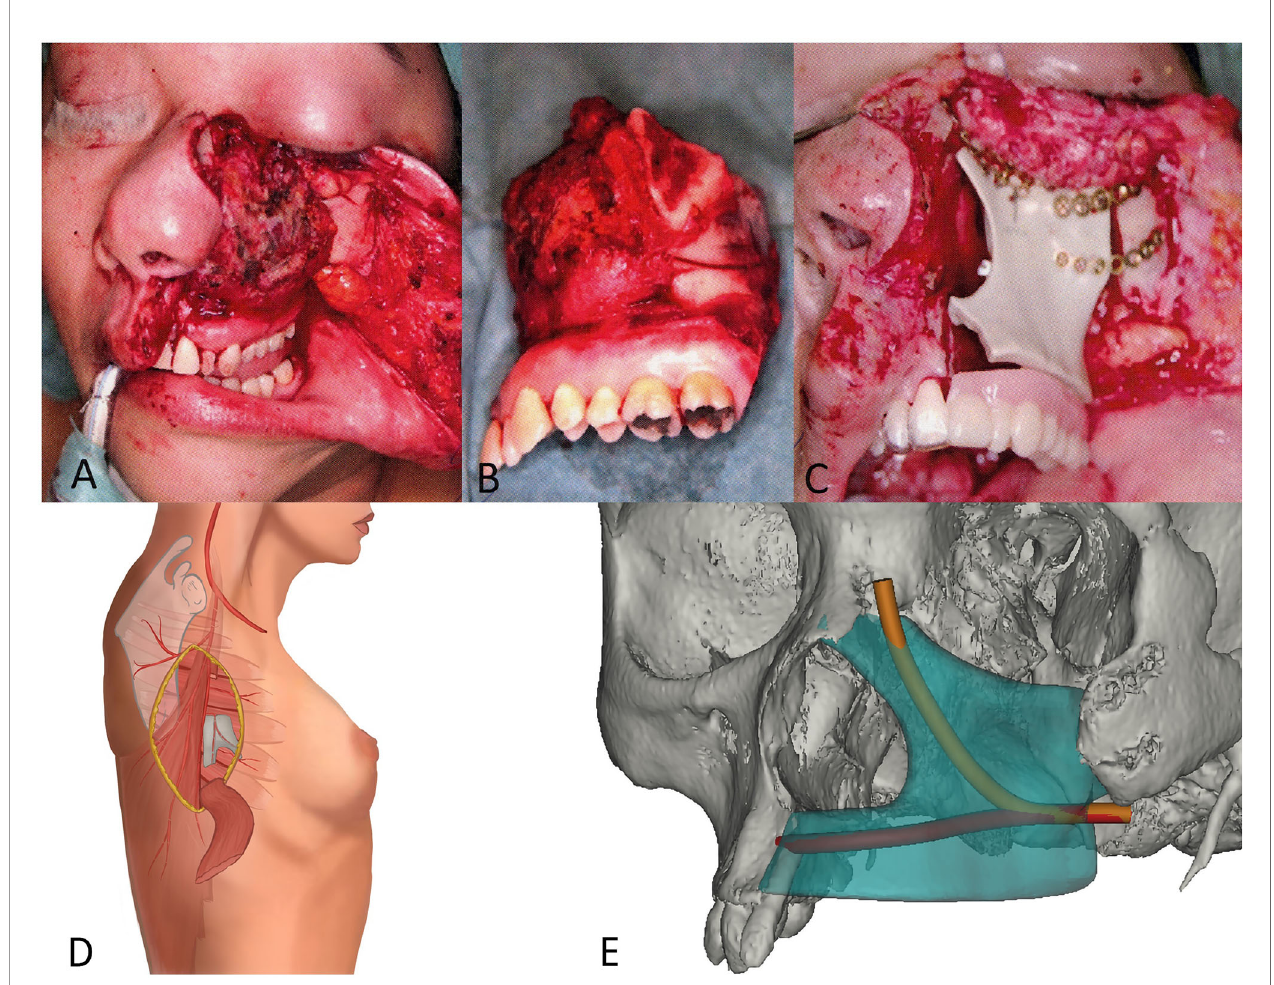
FIGURE 1 | Midface defect, immediate temporary reconstruction, and two-step patient speci fi c planning. (A) Intraoperative aspect of exposed ameloblastic carcinoma of the left hemimaxilla prior to resection. (B) Left hemimaxillectomy specimen with preservation of midface soft tissue and missing inner nasal lining (mucosa). (C) Intraoperative situation after PEEK implantation with obturator prosthesis. (D) Ectopic prevascularization by surgical insertion of an arteriovenous (AV) bundle (serratus branch of the thoracodorsal vessel) and wrapping of the construct into a split latissimus muscle. (E) CAD-CAM reconstruction on the patients CT scan showing the customized Tutoplast ® scaffold with the tunnel planned for the serratus AV bundle and its branching after